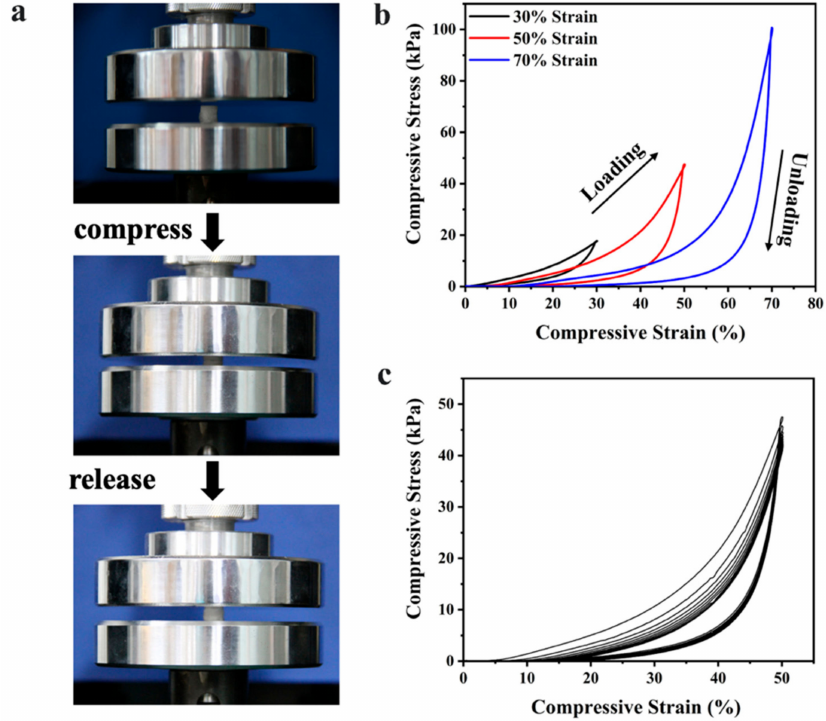
Figure 4. Mechanical compressive properties of AS. ( a ) A set of real-time images of a compressed sample showing the recovering process; ( b ) the cyclic compression stress-strain ( σ - ε ) curves at maximum strain of 30%, 50%, and 70%; ( c ) the cyclic compression stress-strain ( σ - ε ) curves for first 10 cycles at maximum strain of